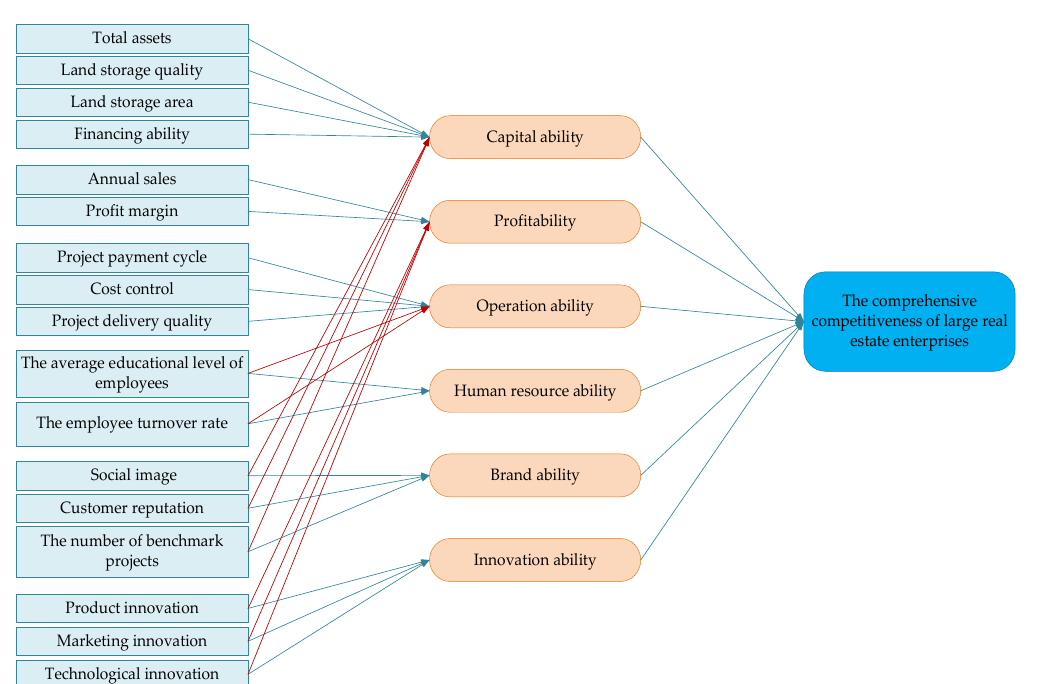
Figure 1. The conceptual model of the internal factors influencing the comprehensive competitiveness of large real estate enterprises.